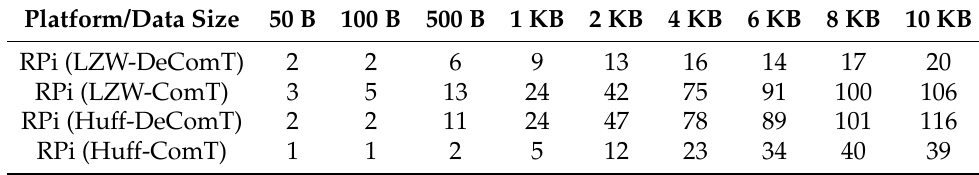
Table 6. Compression (ComT) and Decompression (DeComT) Time (ms). Platform/Data